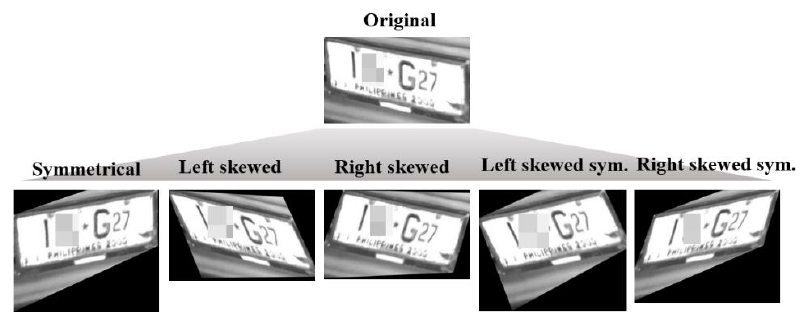
Figure 3. We use five types of augmentation, which are transformation, skewing, or their combination. We train each of the models for 500 epochs on a same GPU, using an Adam optimizer with